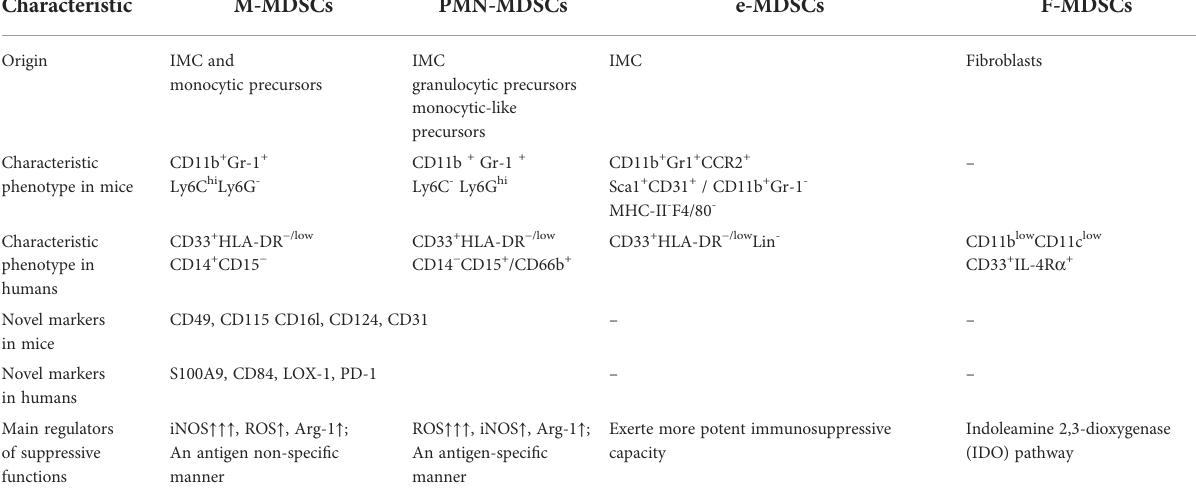
TABLE 1 Classi fi cation and phenotype of